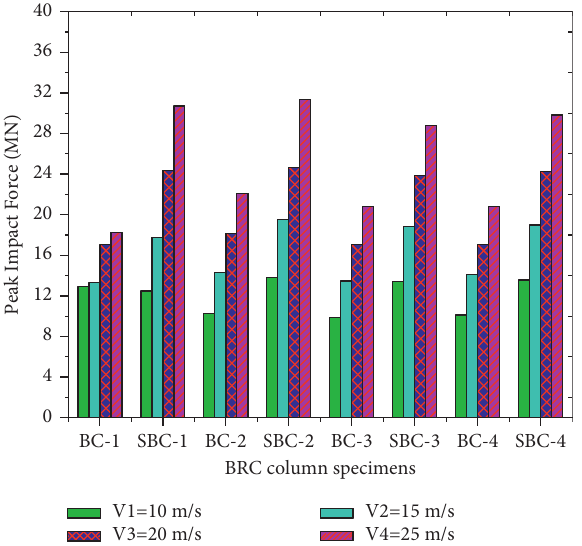
Figure 15: Peak impact force comparisons of BRC columns with and without